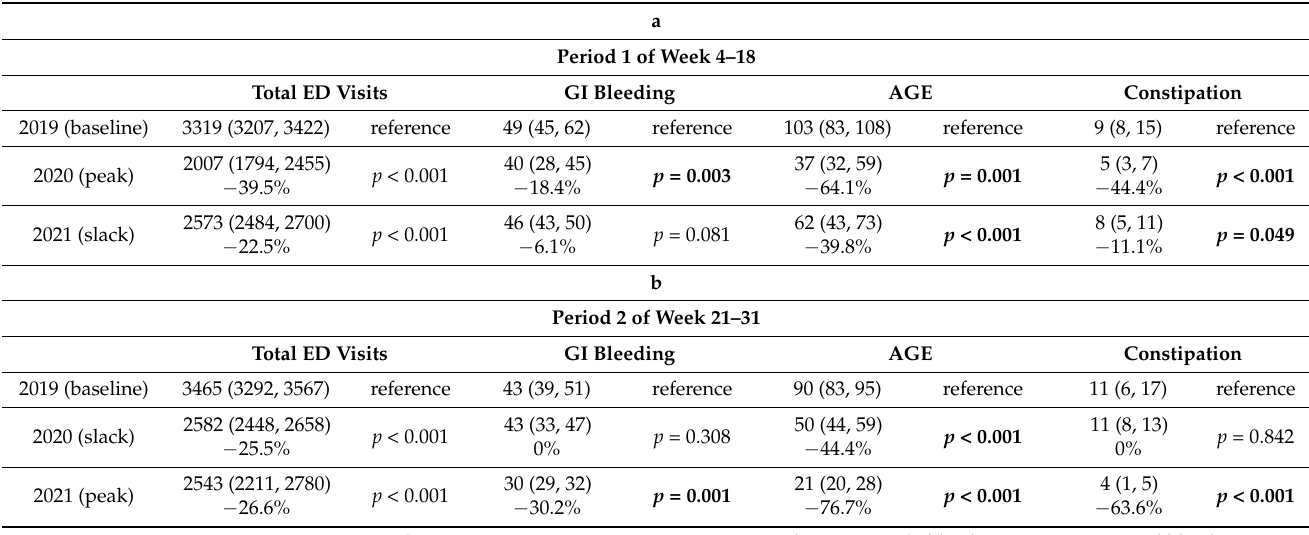
Table 1. Number of ED visits per week, presented by median (IQR), for GI Bleeding, AGE,